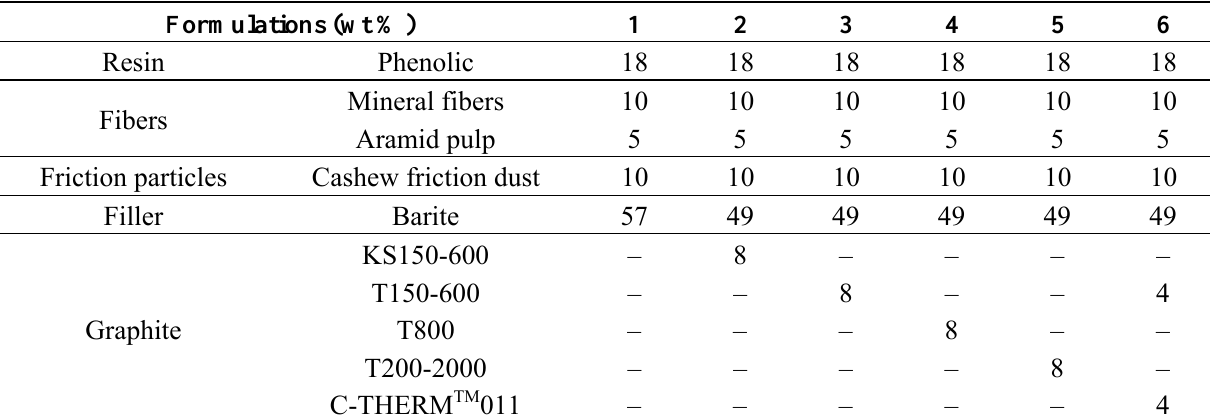
Table 1. Brake pad test